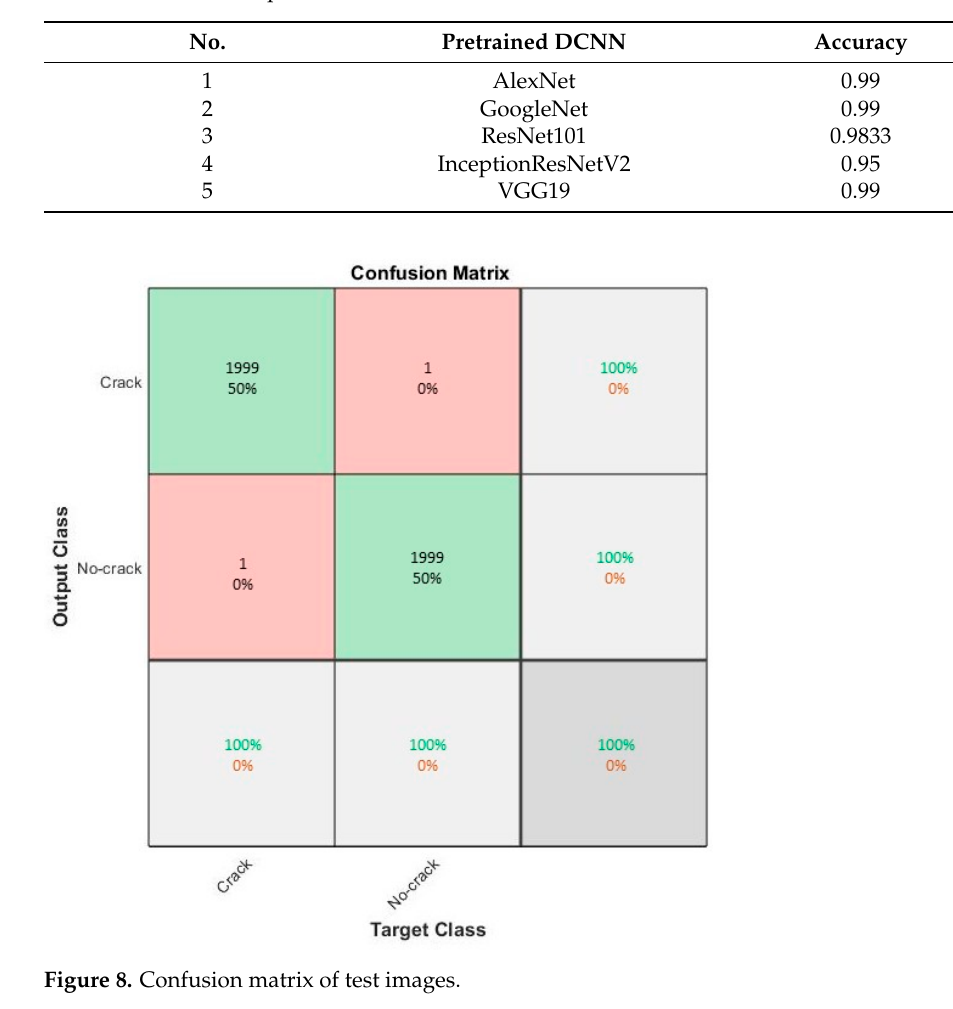
Figure 8. Confusion matrix of test images. Table 6. Performance metrics of the test results.